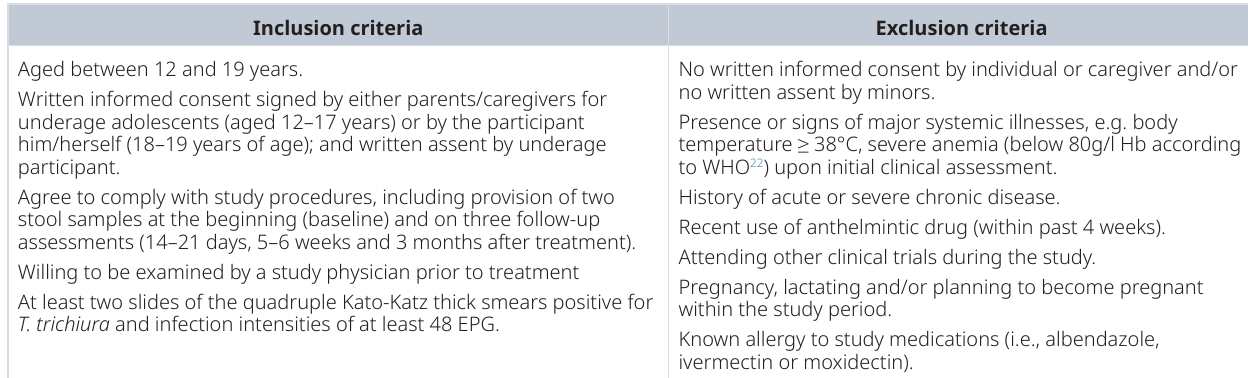
Table 2. Inclusion and exclusion criteria. Inclusion criteria Exclusion